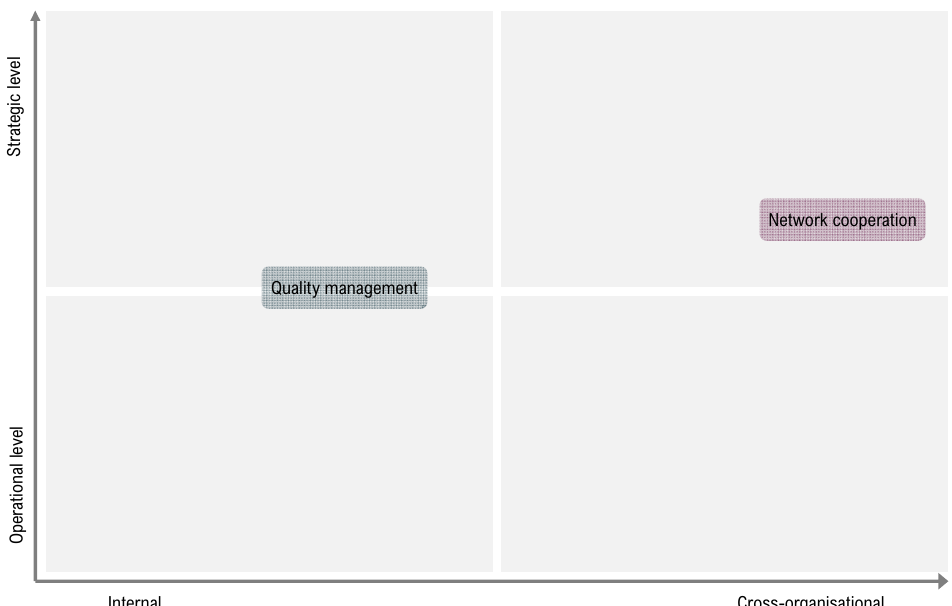
Figure 15. Suggested fields of action for the area-specific intermediate profile.